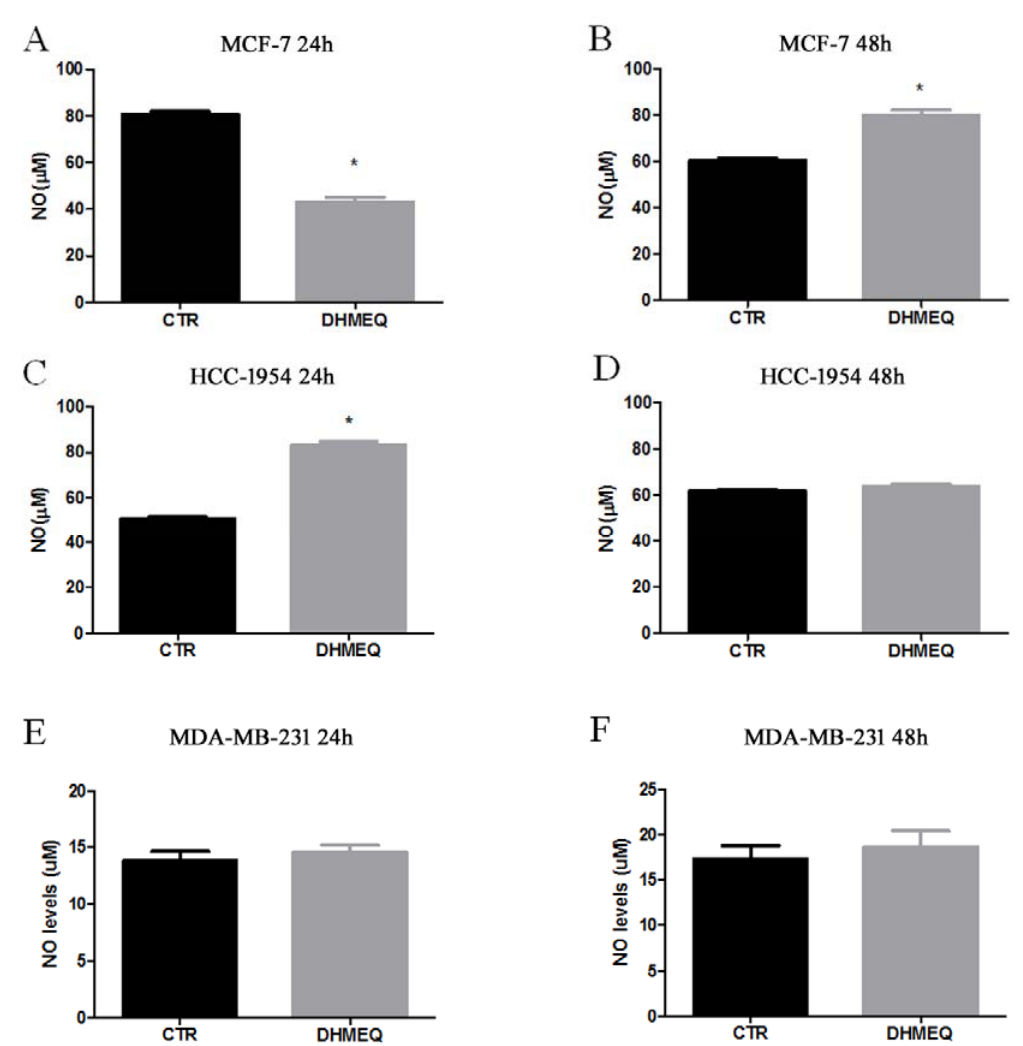
Figure 6. Nitrite as an estimate of NO levels. MCF-7 ( A , B ), HCC ( C , D ) and MDA-MB231 ( E , F ) cells treated (DHMEQ column) or not (CTR column) with NF- κ B inhibitor for 24 or 48 h. Data are expressed as the means and standard errors of the means. * indicates statistical significance ( p < 0.05).